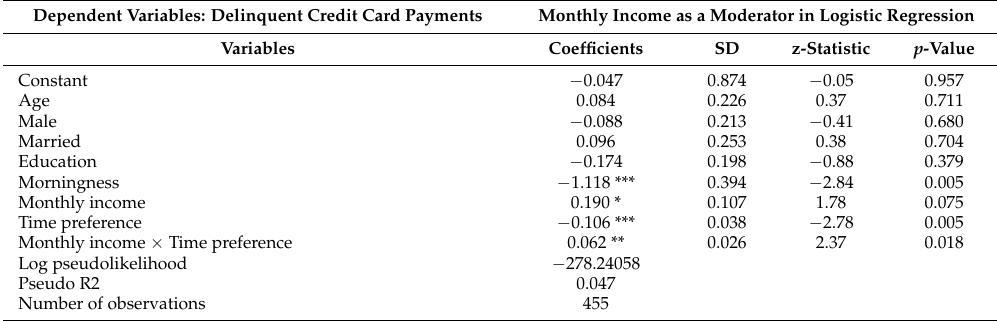
Table 5. The moderation effect of monthly income on the relationship between time preference and delinquent credit card